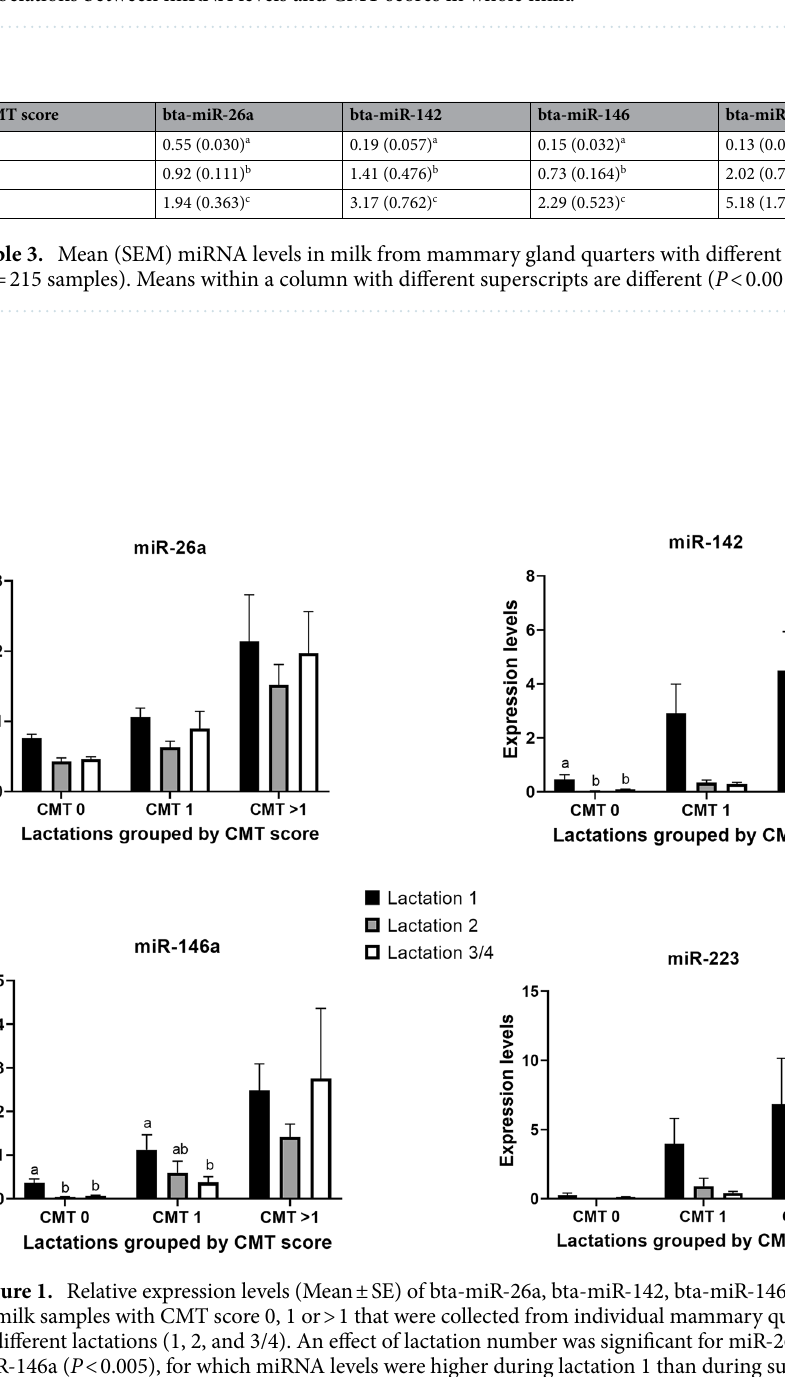
Table 2. Numbers of milk samples within each CMT score and lactation number that were used to analyse the associations between miRNA levels and CMT scores in whole milk.